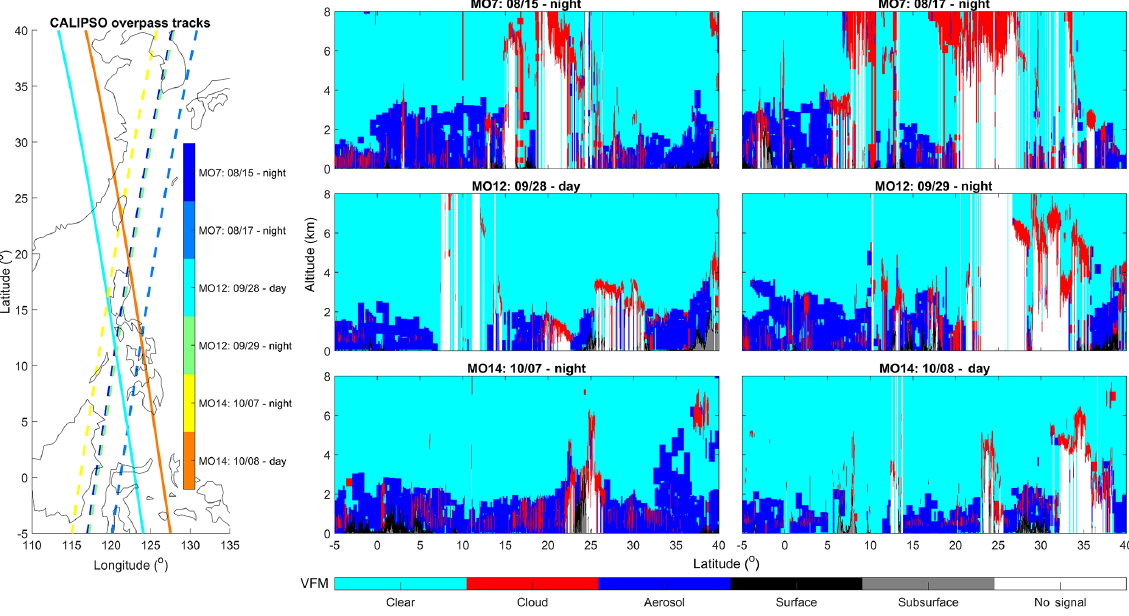
Figure 3. CALIOP Vertical Feature Mask (VFM) for overpasses during or following MO7, MO12, and MO14. For the CALIPSO satel- lite overpass tracks, the dashed lines correspond to the nighttime profiles and solid lines are for daytime. Note that nighttime overpasses correspond to early morning times before sunrise for the listed days and daytime overpasses occurred during the early afternoon.